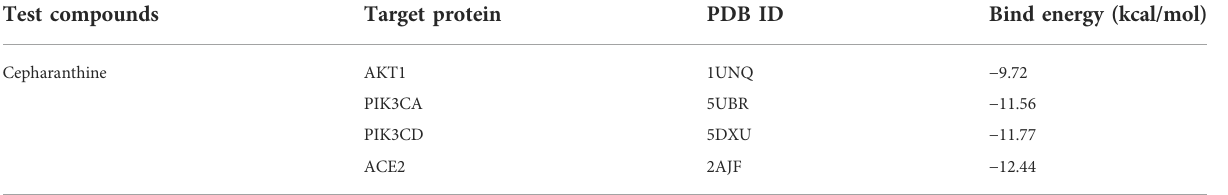
TABLE 2 Molecular binding activity of CEP to target